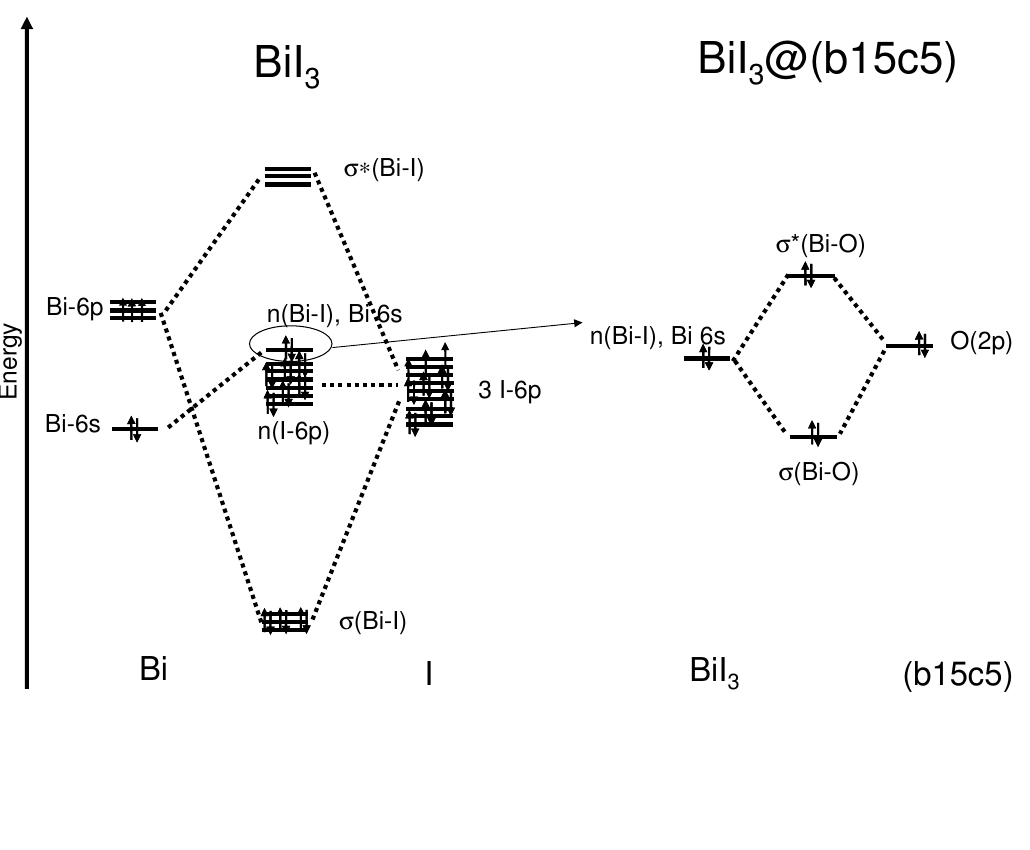
and the crown ether orbitals in 3